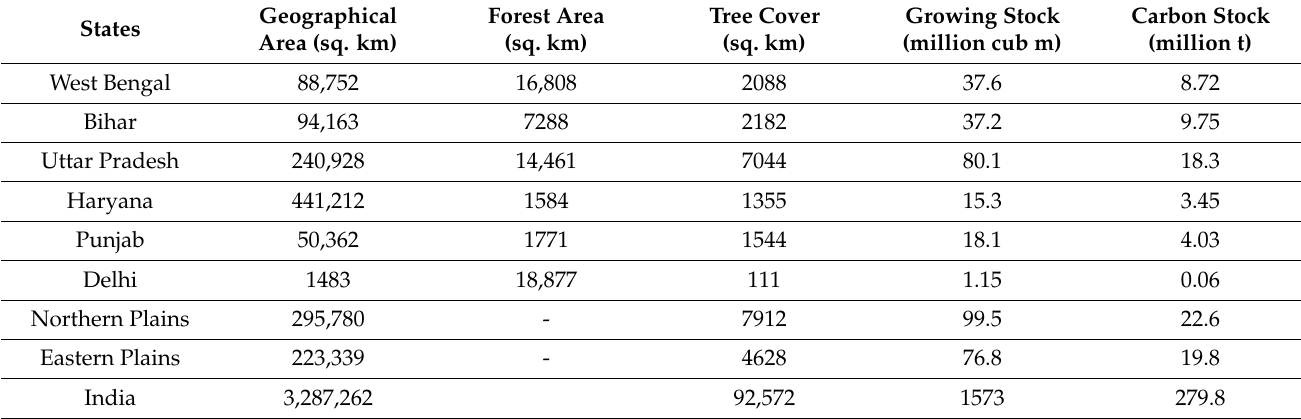
Table 4. Tree cover area, growing stock, and carbon stock in the Indo-Gangetic